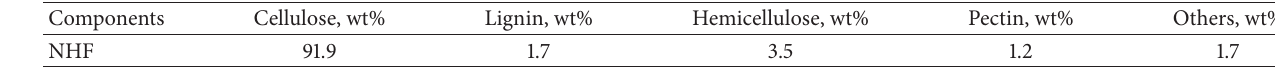
Table 1: The chemical composition of NHF.